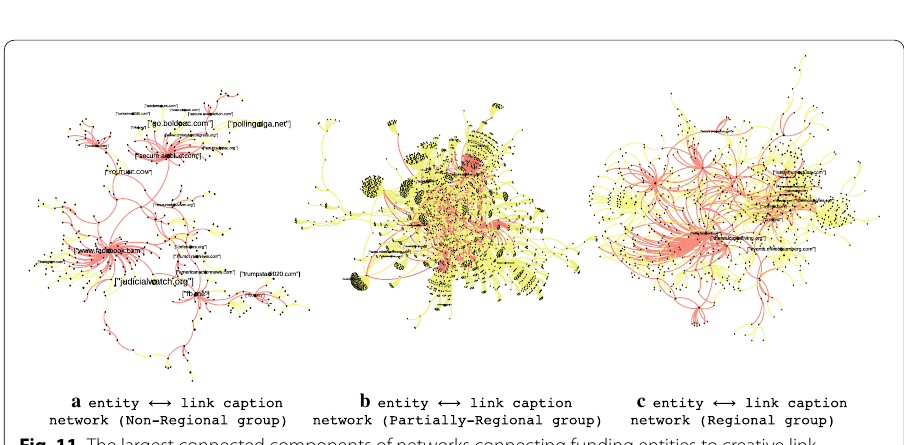
Fig. 11 The largest connected components of networks connecting funding entities to creative link captions their ads are associated with, separated by partition group. From left to right: Non-Regional group, Partially-Regional group, Regional group. Node size and edge weight reflect spend in the network (i.e., on ads that include creative link captions). Link caption nodes are red if they appear in all 3 networks, and yellow if they do not. Entity nodes are grey. All networks were visualized in Gephi (Bastian et al. 2009) using the same layout algorithm (Hu 2005) and same parameters (colors, size, spline,